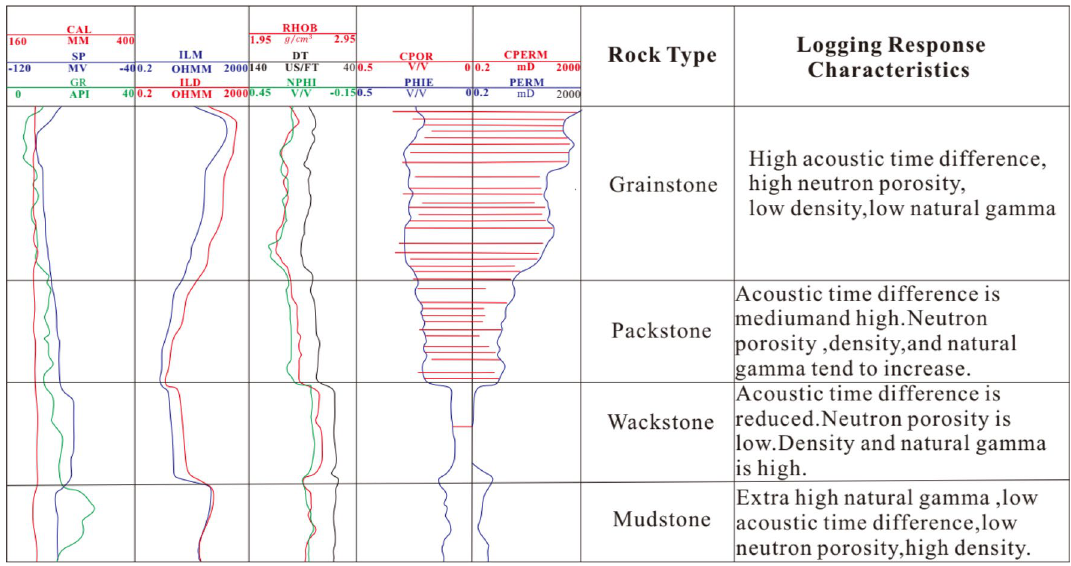
Figure 2. Logging response characteristics of different rock